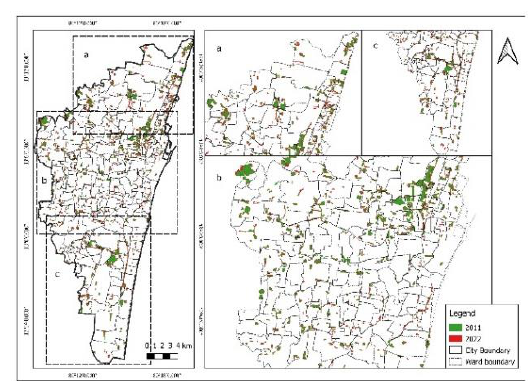
Figure 4. Spatial and temporal analysis of slums for the year 2011 – 2022